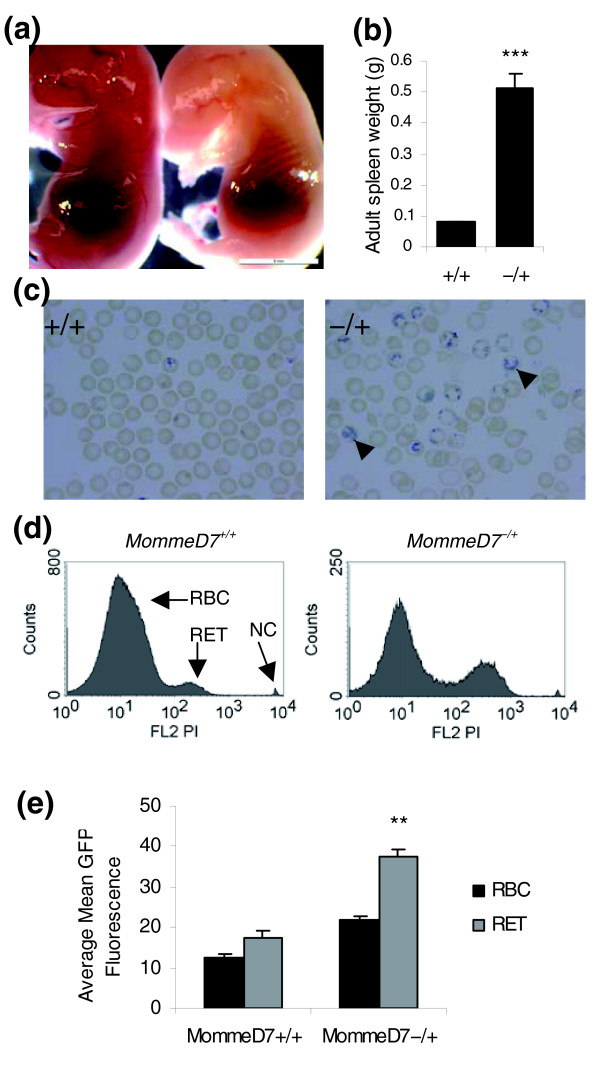
Hematopoietic abnormalities in MommeD7 mice. (a) Examples of phenotypically normal and abnormal (pale) embryos at 17.5 dpc. Abnormal embryos are assumed to be homozygous for MommeD7. Scale bar = 5 mm. (b) Spleen weights from MommeD7+/+ and MommeD7-/+ adult mice. Error bars represent SEM. ***p < 0.0001. (c) Blood smears from MommeD7+/+ (left) and MommeD7-/+ (right) mice stained for reticulocytes (shown with arrowheads). (d) Representative histograms showing propidium iodide fluorescence in MommeD7+/+ (left) and MommeD7-/+ (right) mice. In each case 10,000 reticulocytes were counted. Red blood cells (RBC), reticulocytes (RET) and nucleated cells (NC) are shown. (e) Histogram showing relative levels of GFP fluorescence in red blood cells and reticulocytes. Averages were calculated from three wild-type and three heterozygous mice. **p < 0.005; error bars represent SEM.